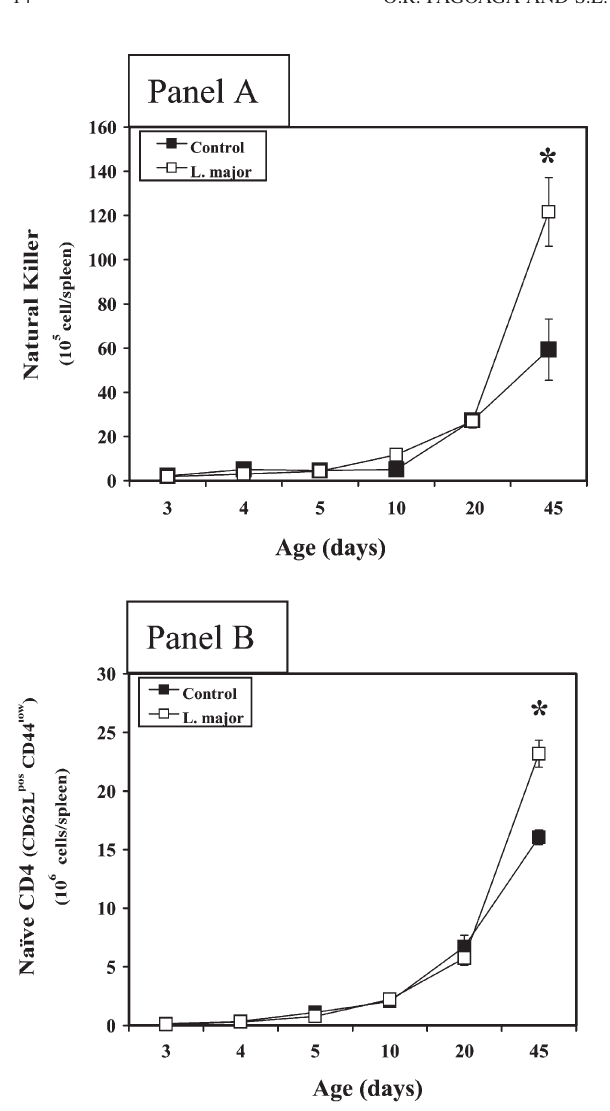
FIGURE 4 Natural killer (NK, Panel A) and naive Th cells (CD62LposCD44low, Panel B) in spleens of pups of various ages delivered from dams treated during gestation with saline or L. major (175ug/mousei.p.insaline).Datapointsare mean ^ SE of5samples/age, except 6 on d20 in saline group; and 5 sample/age for L. major . Samples represent pools of randomized pups (d3-10, 5–14/pool; d20, 2/pool; d45, 1 pup). Statistical significance ( p , 0 : 05; df ¼ 5; F ¼ 8 : 27 for NK and 16.2 for naive) for treatment effects among groups was derived from two- way ANOVA. Post hoc analysis with Student’s t -test (two-tail) to reveal differences among groups per age (*, p , 0 : 05; df ¼ 8; t statistic of 2.99 (NK)and5.4(naı¨ve)).See“Statisticalanalysis”sectionforfurtherdetails. At some ages, symbols obscure SE bars.